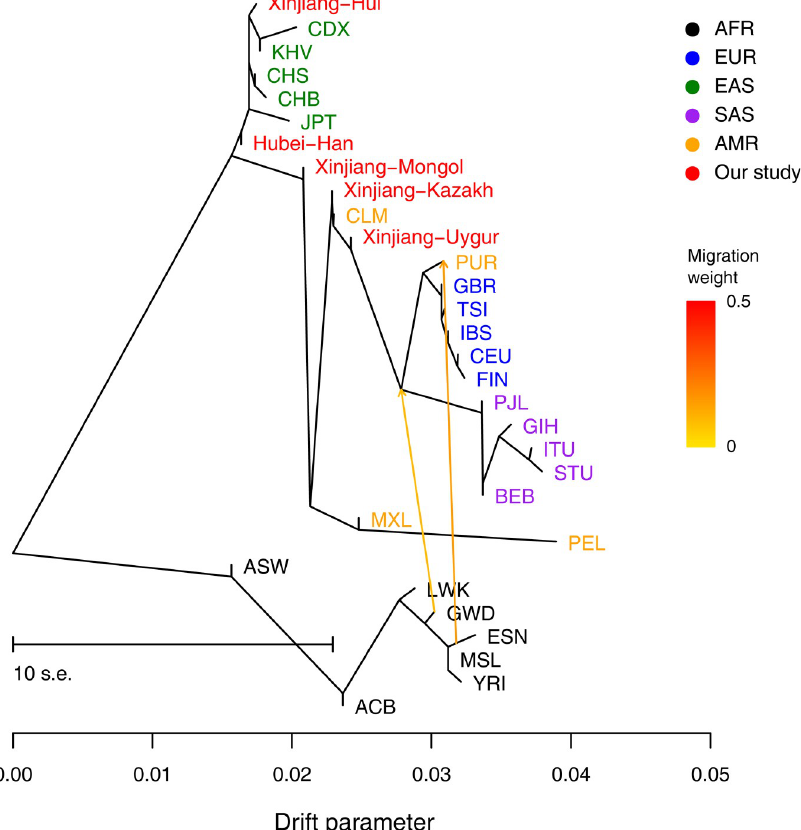
Fig 3. The maximum likelihood tree showed the patterns of population splits and genetic admixture with two migration event. The YRI, ESN, MSL, GWD, LWK, ACB and ASW samples were set as the outgroup. Horizontal branch lengths are proportional to the amount of genetic drift that has occurred on the branch. The scale bar shows ten times the average standard error of the entries in the sample covariance matrix. The residual fit from this graph is shown in S2